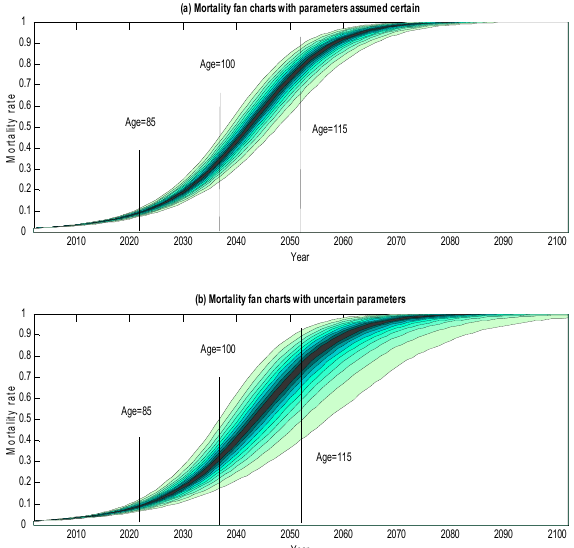
Figure 1. Mortality Fan Charts for Cohorts of Males Currently Aged 65 Years Old. Notes: The chart shows the central 10% prediction interval with the heaviest shading, surrounded by the 20%, 30%, …, 90% prediction intervals with progressively lighter shading. Estimated using 10,000 Monte Carlo simulation trials with the mortality model of Cairns et al. [12] calibrated on Government Actuary’s Department (GAD) data over the period